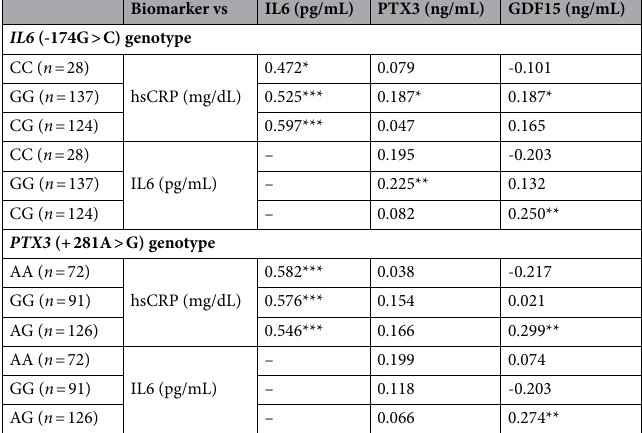
Table 5. Correlations between the inflammatory markers, within each IL6 and PTX3 polymorphic genotype, in end-stage renal disease patients ( n = 289). * p < 0.05; ** p < 0.01; *** p < 0.001 correlations between parameters for each IL6 or PTX3 polymorphic genotypes (Spearman’s rank correlation r ). GDF15 growth differentiation factor 15, hsCRP high-sensitivity C-reactive protein, IL6 interleukin 6, PTX3 pentraxin 3.